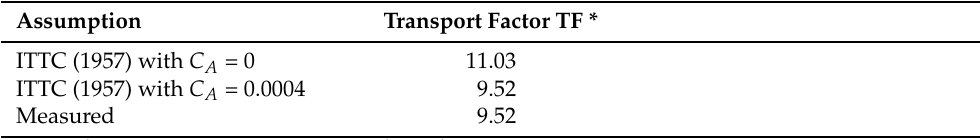
Table 3. Transport factor of the Sydney